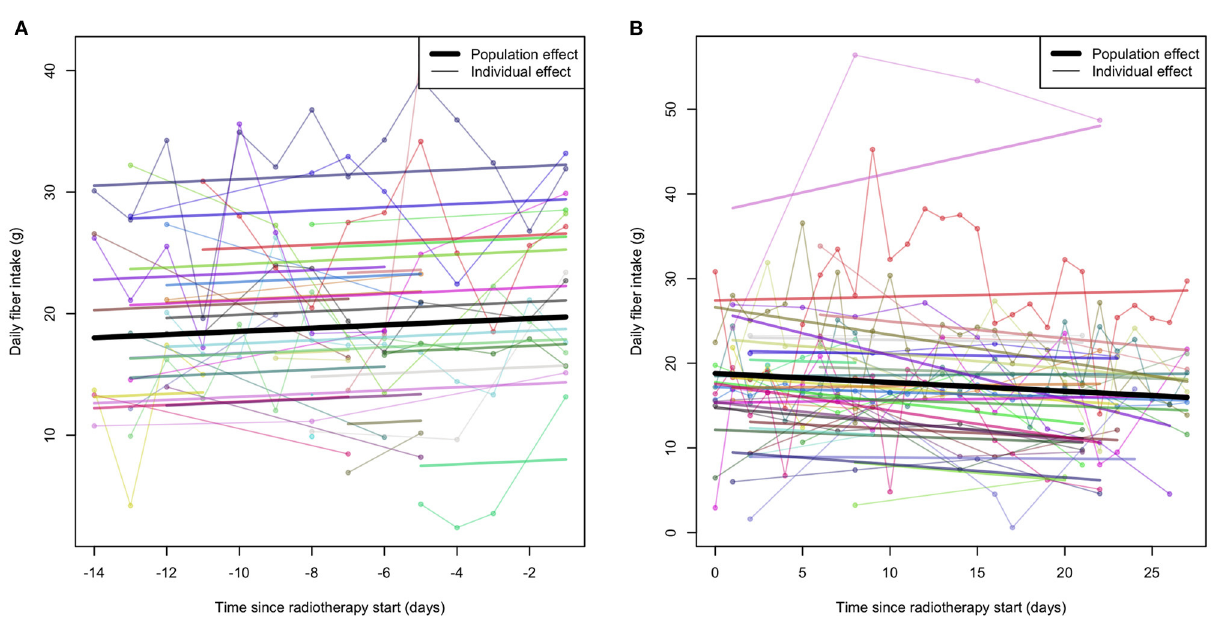
FIGURE 3 | Individual total intake of dietary fiber (g) per day registered by the application. Regression lines were estimated using linear mixed-effects models allowing for random intercepts and slopes at the individual level. (A) Shows the intake before the start of the radiotherapy ( n = 24). (B) Shows the intake after the start of the radiotherapy ( n =